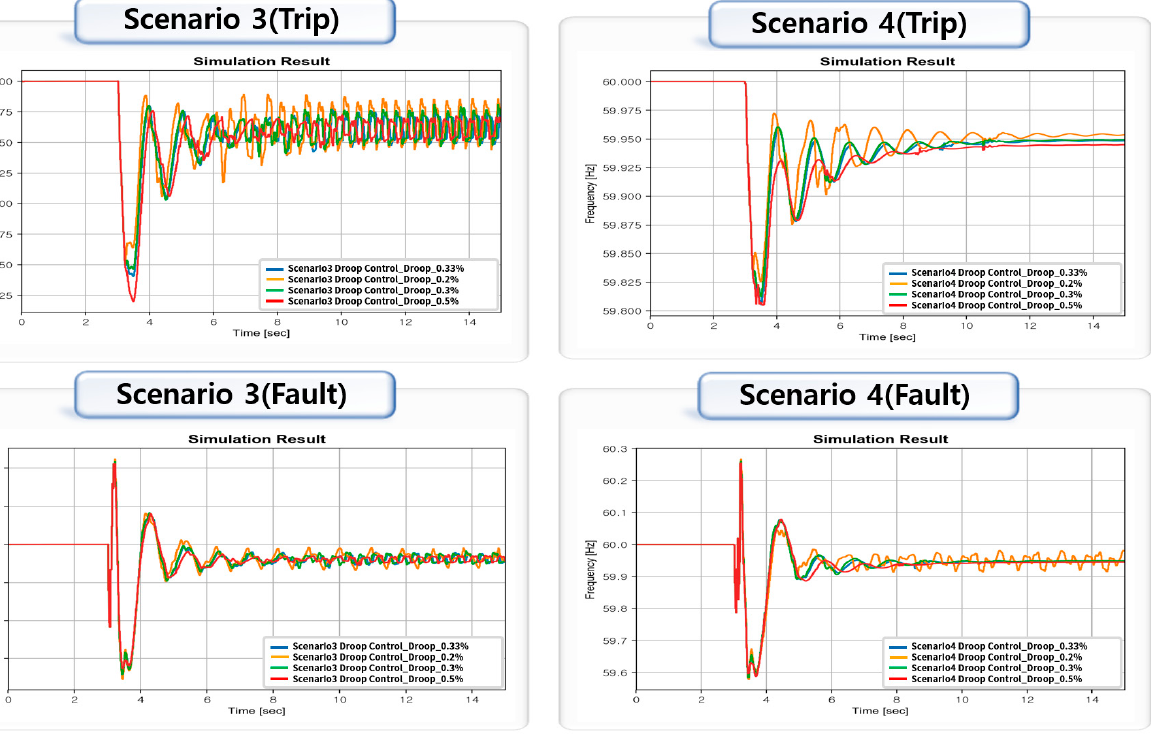
Figure 12. Frequency response by ESS parameter (droop control).